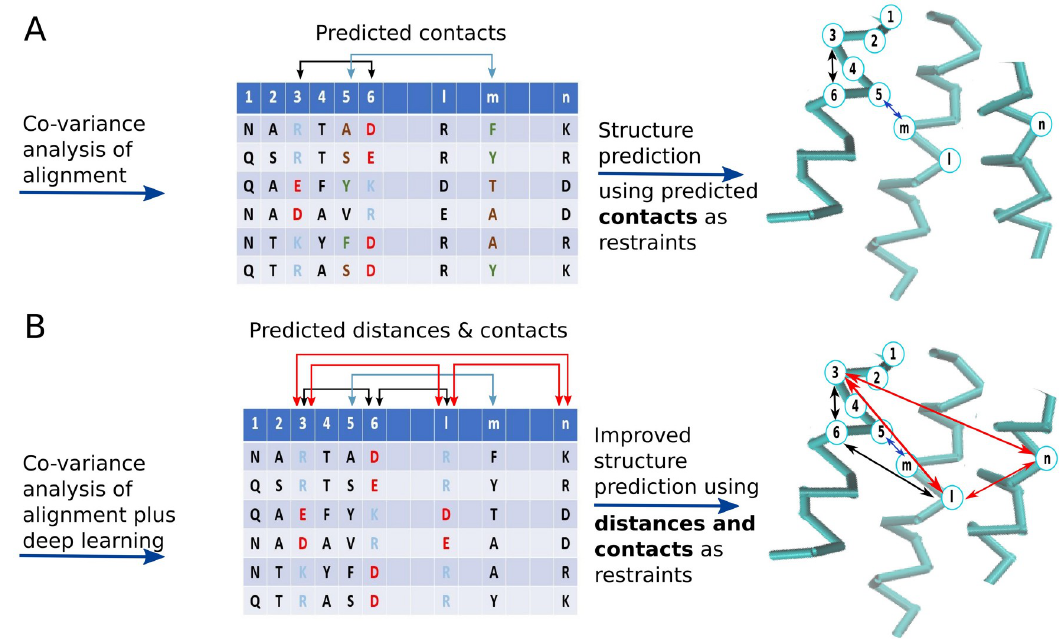
Fig 1. Co-variance between columns of a multiple sequence alignment can be used to predict inter-residue contacts and distances and thence protein